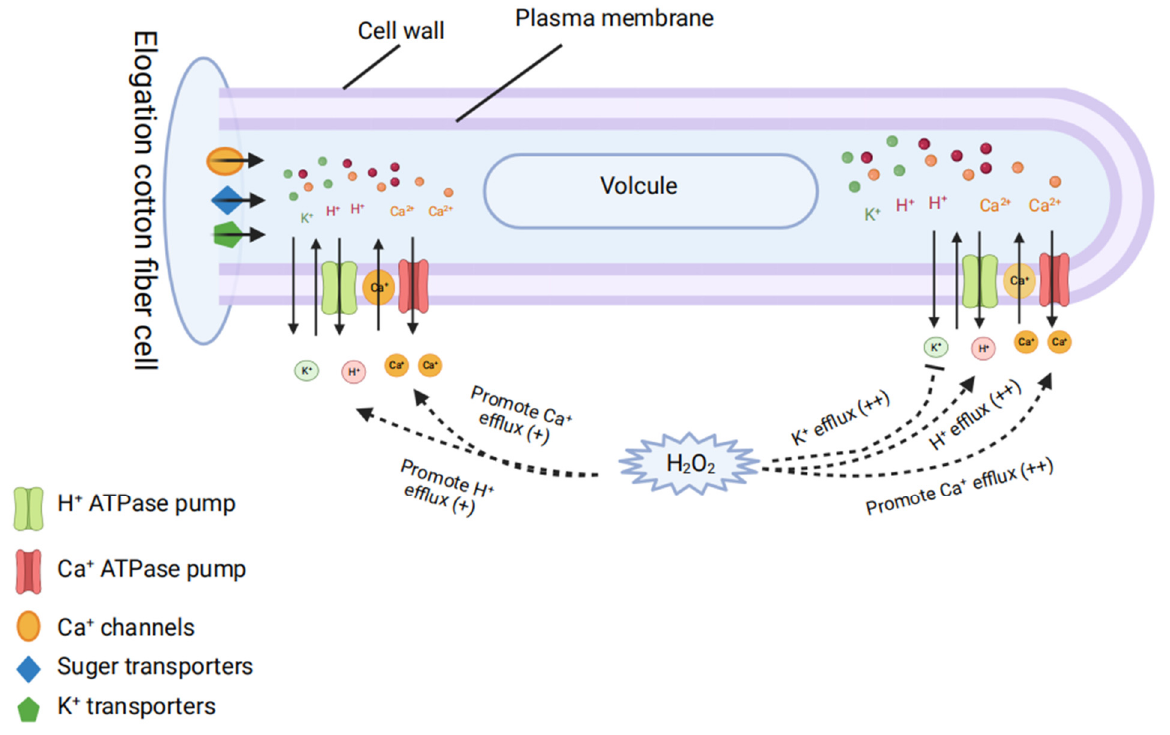
Figure 5. A schematic model of how cotton fiber cells grow, with Ca 2+ , K + , and H + channels and ion efflux. Ca 2+ , K + , and H + channels and efflux fluctuations are observed in both the tip and the base of the elongating fiber cells that were treated with H 2 O 2 .